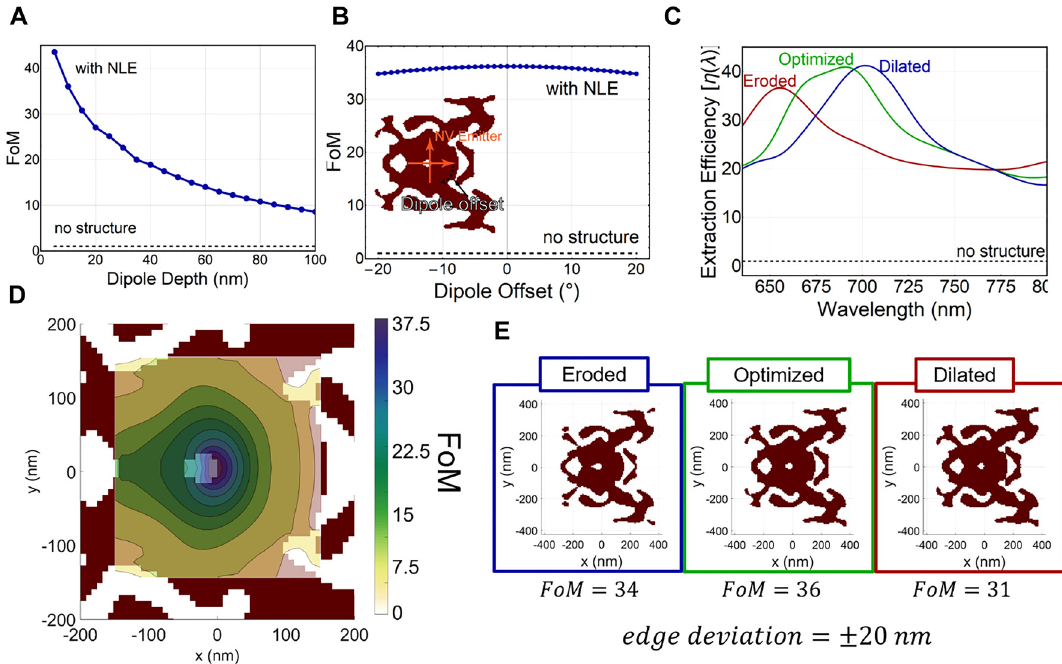
Figure 4: (A) The NLE maintains good performance through a range of depths, with increasing FoM for NVs closer to the surface. (B) FoM dependence on the NV emitter angle emulating angular alignment errors of the NLE. (C) Demonstration of the fabrication robustness of the optimized device for an NV depth of 10 nm. Eroded and dilated structures are based on the optimized structurewith edge deviation of ± 20 nm torepresentfabricationunder/over-etching,respectively.Owingtothebroadbandnatureofouroptimization,theNLEshowsstrongtolerance tofabricationerrors.(D)ToleranceoftheNLEtolateraloffsetsoftheNVcenter.TheFoMremainsabove25for X offsetsof ± 30nmand Y offsets of ± 40 nm. (e) The geometries of the eroded, optimized, and dilated devices simulated in c. The edge deviation refers to how far the edges shifted inward for the eroded or outward for the dilated cases. FoM, fi gure of merit; NLE, nanoscale light extractor; NV,